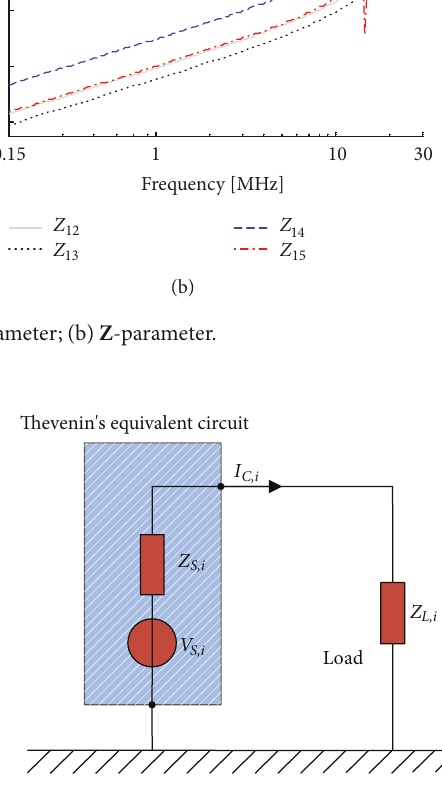
Figure 6: Measuring of electronic